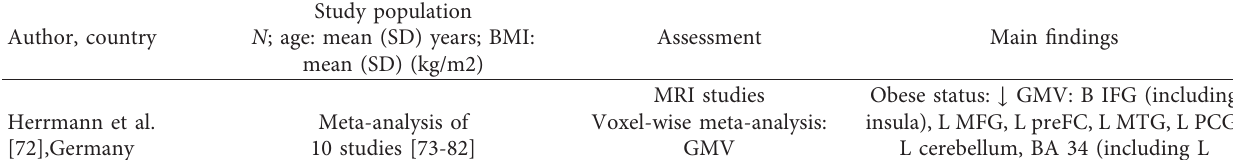
Table 2: Characteristics and summary results of neuroimaging studies on